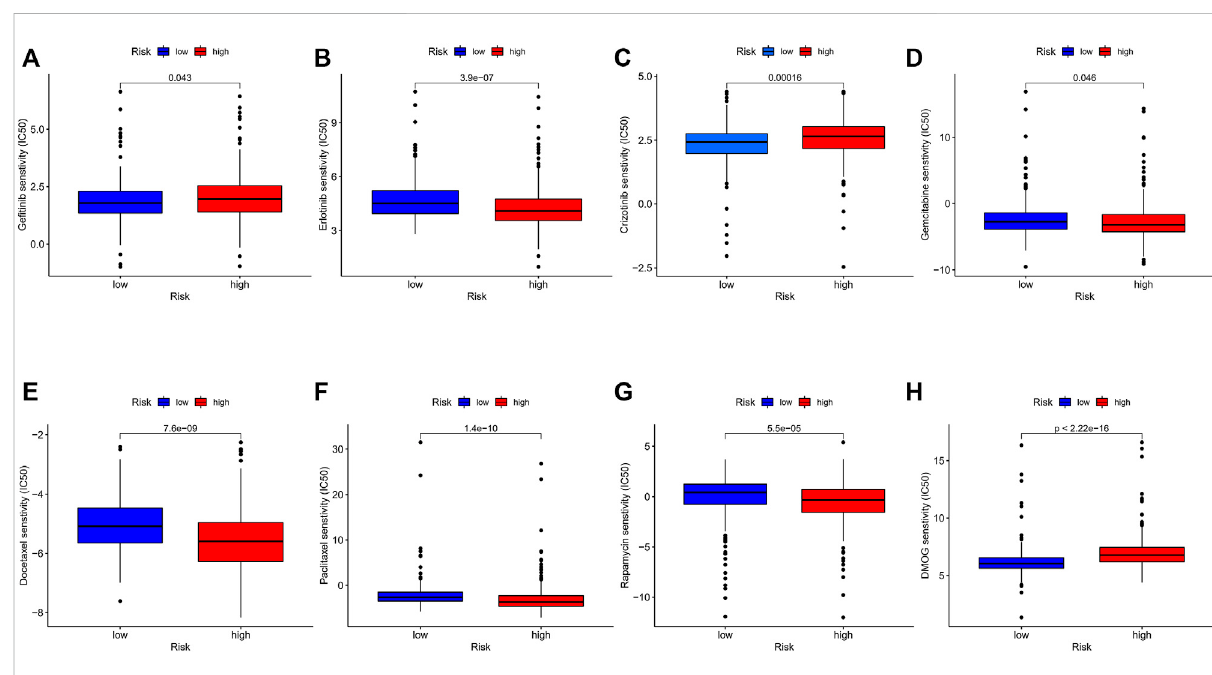
FIGURE 9 (A – H) Comparison of IC50 between different risk groups. (wilcox.test, p values were as follows: * p < 0.05; ** p < 0.01; *** p < 0.001).